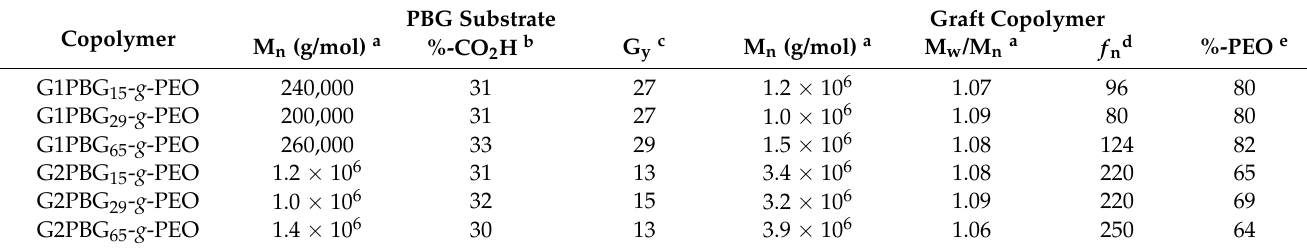
Table 2. Characteristics of randomly grafted PBG- g -PEO arborescent copolymers.